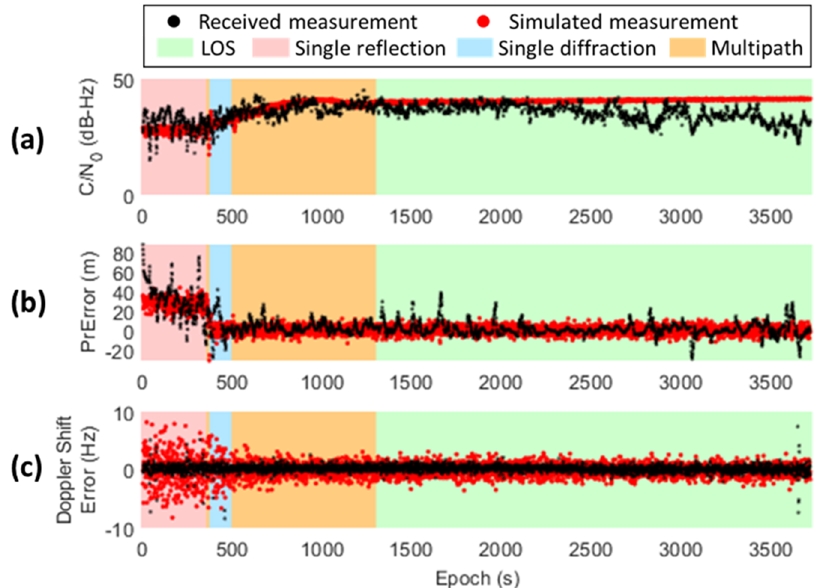
Figure 12. The comparison of the simulated and actual received GNSS measurements from G20 satellite during the one-hour static experiment, including: ( a ) C / N 0 ; ( b ) pseudorange error; ( c ) Doppler shift error. The colored background denotes the measurement status being categorized during the simulation, including: LOS, single reflection, single diffraction, and multipath.